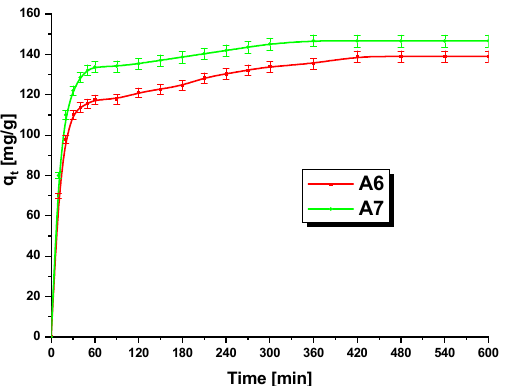
Figure 9. Influence of contact time on the adsorption of methylene blue on samples A6 andA7 (biochar mass: 20 mg, initial dye solution concentration: 60 mg/L, volume of methylene blue solution: 50 mL, temperature: 22 ± 1 ◦ C).